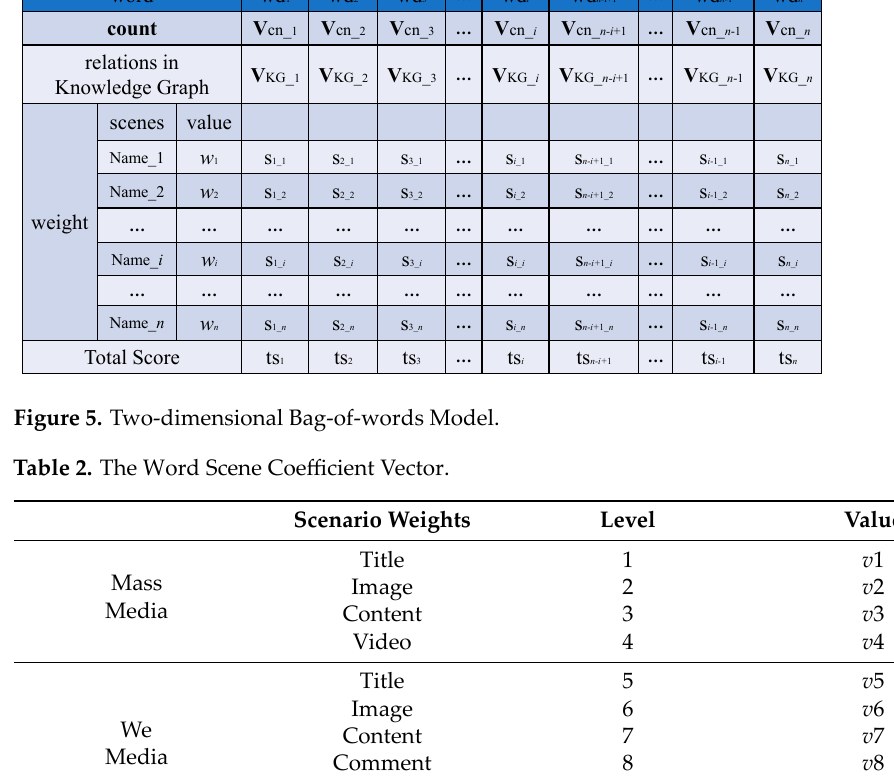
Table 2. the Word Scene Coe ffi cient Vector.